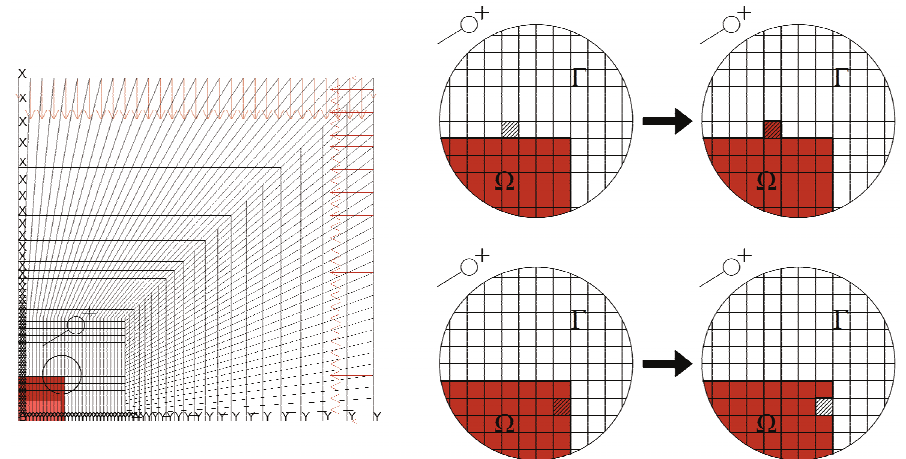
Fig. 2. Two types of permissible changes in